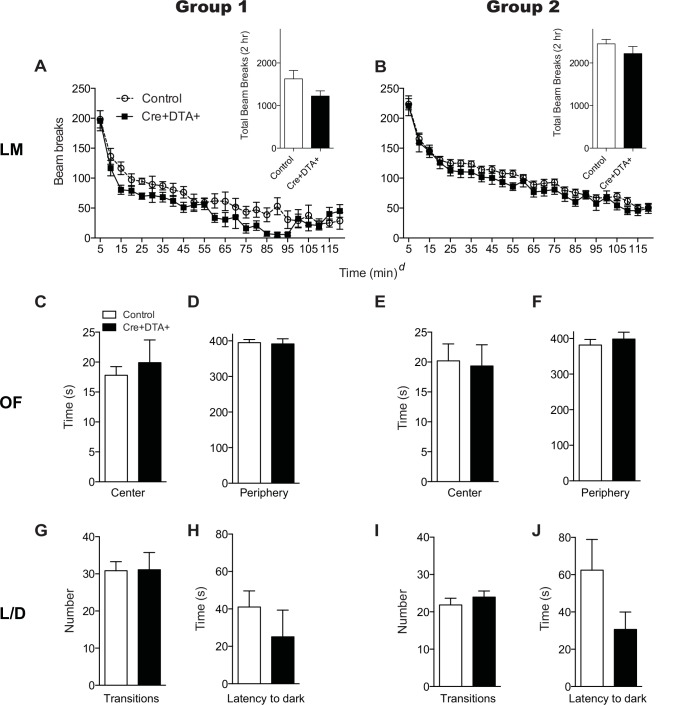
Cre+DTA+ mice tested less than or more than 4 weeks post-TAM show similar levels of locomotion and the absence of baseline anxiety-related behaviors.(A, B) Locomotor activity (LM) in both short (A, Group 1, control N = 8, Cre+DTA+ N = 5) and long (B, Group 2, control N = 33, Cre+DTA+ N = 13) TAM-beh interval groups. Insets A, B: total beam breaks over 2 hr. Main panels A, B: beam breaks over 2 hr presented in 5 min bins. X axis * = main effect of time. Posthoc analysis (Bonferroni) revealed all points in main panels were significantly different than the initial locomotor activity data point. However, individual data point asterisks are omitted for clarity, as there was no main effect of genotype or interaction of time X genotype for either Group 1 or Group 2. (C-F) Time spent in the center (C, E) and periphery (D, F) during an open field test (OF) in short (C-D, Group 1, control N = 30, Cre+DTA+ N = 9) and long (E-F, Group 2, control N = 42, Cre+DTA+ N = 17) TAM-beh interval groups. (G-J) Number of transitions between light and dark chambers (G, I) and latency to enter the dark chamber (H, J) in the light/dark test (L/D test) in both short (G-H, Group 1, control N = 30, Cre+DTA+ N = 9) and long (H-I, Group 2, control N = 38, Cre+DTA+ N = 17) TAM-beh groups. Data are mean±SEM. dp<0.0001, two-way ANOVA with repeated measures and Bonferroni posthoc (A, B). *p<0.05, unpaired two-tailed Student’s t-test (insets A, B, and C-H).